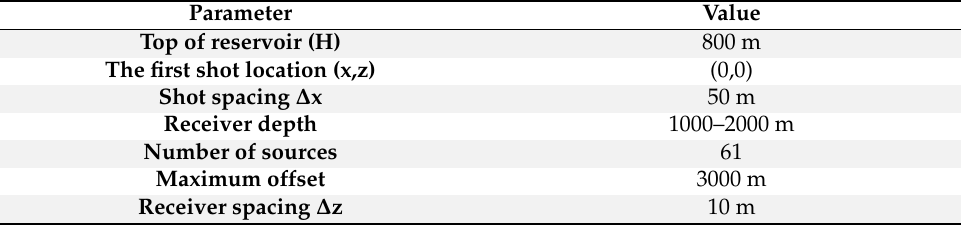
Table 2. VSP survey parameter simulation with the CTP configuration for the TAVO study.